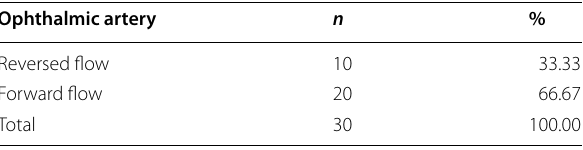
Table 3 Distribution of study population as regards ophthalmic